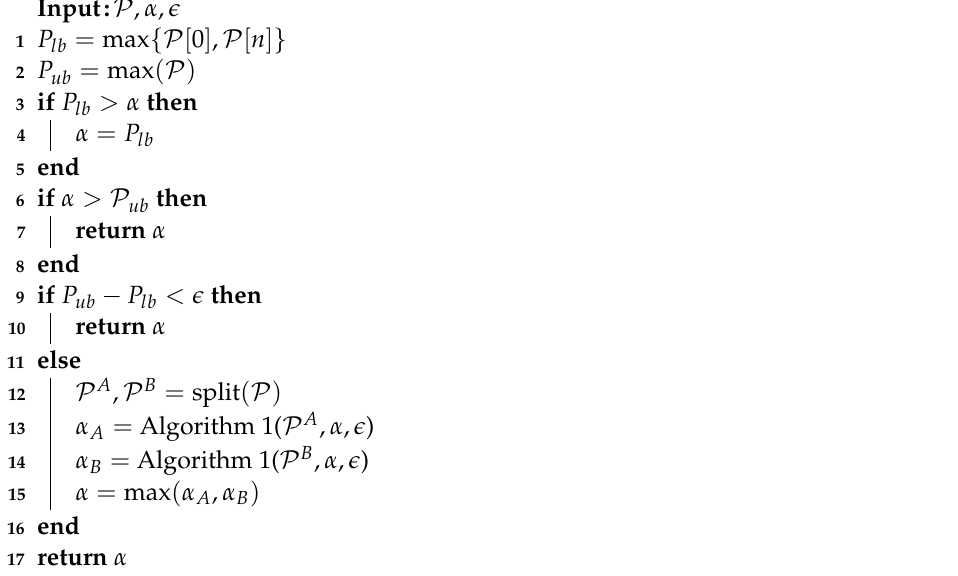
Algorithm 1: Evaluating Maximum Value of a Bernstein